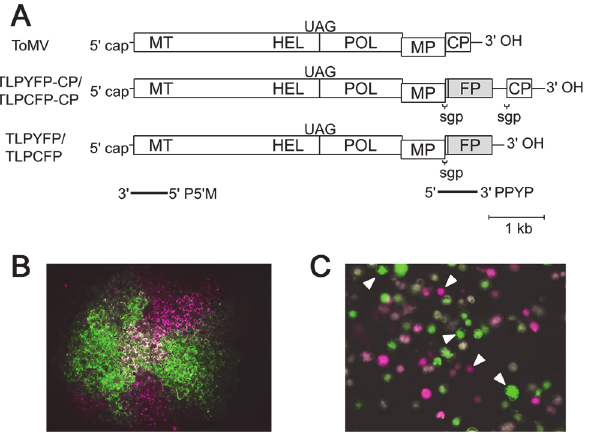
Fig 1. Estimation of founder numbers during cell-to-cell spread in leaf tissues after protoplast infection by ToMV. (A) The genome structure of wild-type ToMV and its derivatives used in the experiments. Rectangles indicate open reading frames (ORFs). MT, a methyltransferase-like domain; HEL, a helicase-like domain; POL, a polymerase-like domain of the replication proteins; MP, the cell-to-cell movement protein; and CP, the coat protein. Translation of the genomic RNA produces two replication proteins, 130K and 180K; 130K contains MT and HEL. The 180K is synthesized via the UAG stop codon read-through of 130K to express POL. FP indicates the fluorescent protein genes (YFP or CFP). TLPYFP-CP and TLPCFP-CP carry the YFP and CFP gene, respectively, between the MP and CP coding regions. The expression of the YFP or CFP genes is driven by a duplicated subgenomic promoter (sgp) for the CP. TLPYFP and TLPCFP lack the CP gene. The regions that correspond to the PPYP and P5 0 M probes, which were used for northern blotting and RNase protection assays, are indicated by bold lines. (B) An example of spatial separation of the two variants during cell-to-cell spread from a coinfected cell in a tobacco leaf. YFP and CFP fluorescence images were obtained separately 44 hours postinoculation (hpi) using a color charge-coupled device (CCD) camera. After converting the color of the CFP fluorescence image to magenta, the image was merged with the YFP fluorescence image without color conversion. The YFP images look green (rather than yellow) because of the transmission range of the emission filter. Coinfected cells were found at the central part of the infected region as white colored cells. (C) The stochastic occurrence of single infections by one of the two co-inoculated variants in protoplasts. Fluorescence images were obtained at 24 hpi and then processed as described above. White arrowheads indicate singly infected